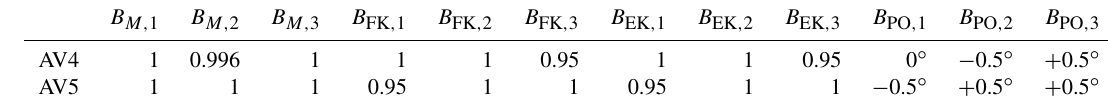
Table 2. Identified simulation model imbalances. Values without units are factors that are multiplied with the given parameter.